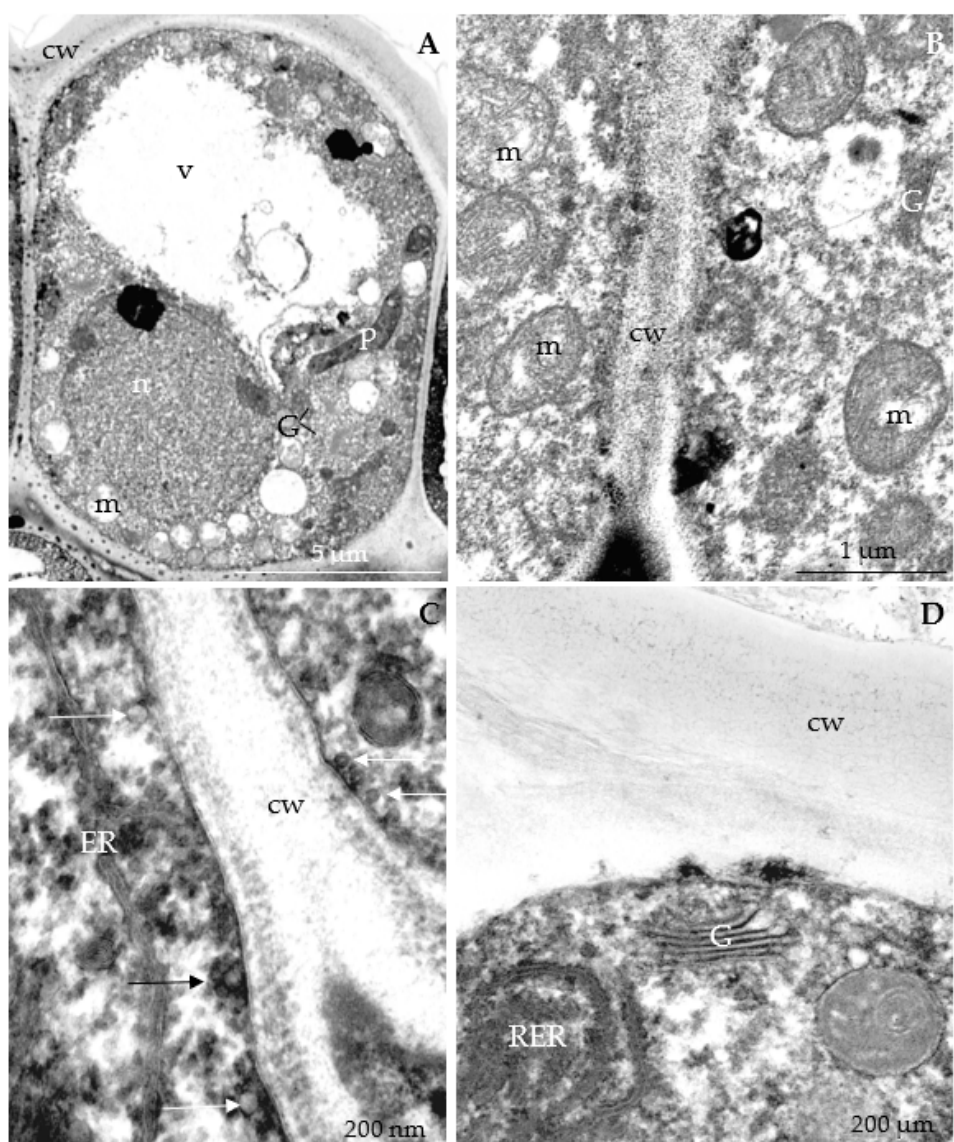
Figure 22. ( A – D ). Fragments of nectary epidermis ( A , D ) and parenchyma ( B , C ) cells in R. idaeus ‘Polka’ in the full secretion phase. ( A ): mitochondria (m) arranged serially between the nucleus (n) and the cell wall (cw), large vacuole (v), pleomorphic plastids (p). ( B ): Golgi apparatus (G), mitochondria (m) located near the cell wall (cw). ( C ): tubular endoplasmic reticulum (ER), transport vesicles (arrow). ( D ): outer cell wall (cw), Golgi apparatus (G), rough endoplasmic reticulum Table 5. Thickness of the cell wall of the nectary epidermis in R. idaeus cultivars (µm). R. idaeus Trait ‘Glen Ample’ ‘Laszka’ ‘Radziejowa’ ‘Pokusa’ ‘Polana’ ‘Polka’ Mean ± SD